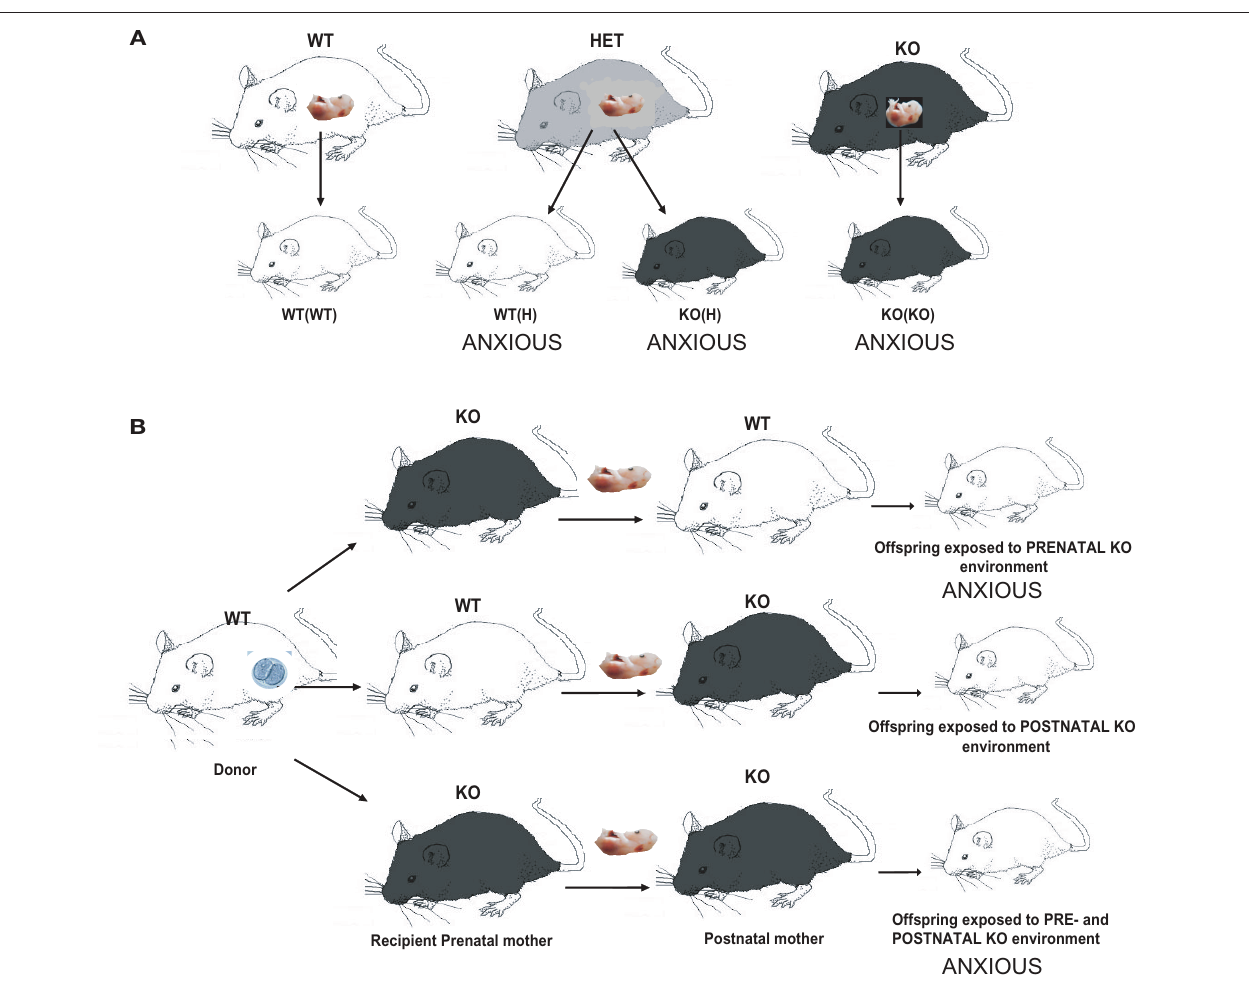
Figure 1 | Diagram showing breeding and embryonic cross-fostering schemes for the 5-HT1A receptor deficient line. (A) WT mice are bred together to generate WT(WT) control animals with neither a maternal nor an offspring 5-HT1A receptor effect. Homozygous 5-HT1A receptor knockout mice are bred together to generate KO(KO) mice with both a maternal and an offspring 5-HT1A receptor genotype effect, which display increased anxiety-related behavior in the elevated plus maze. WT and 5-HT1A receptor homozygous knockout mice are bred together to generate 5-HT1A receptor heterozygotes, which are intercrossed to generate both WT(H) and KO(H) mice, both of which also display